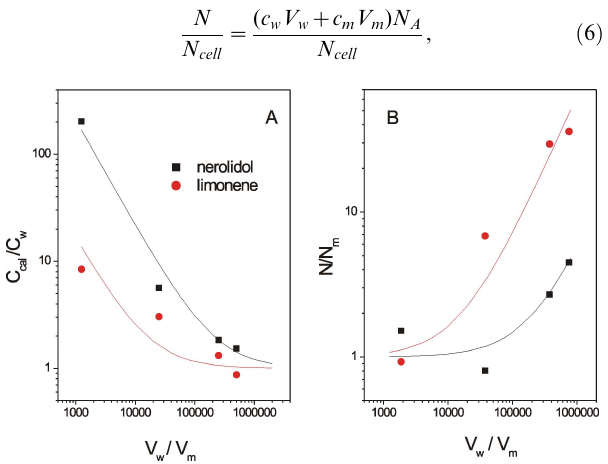
Figure 3. Theoretical and experimental IC 50 dependencies on the cell concentration. (A) Theoretical curves calculated from eq. 4 (see text for details) for the molar concentration ratio c cal /c w in comparison with the IC 50 values shown in Table 1 for different cell concentrations of nerolidol (square) and ( + )-limonene (circle) as a function of V w /V m . (B) Theoretical curves calculated from eq. 8 for the ratio N/N m compared with the IC 50 of nerolidol and ( + )-limonene versus V w /V m .